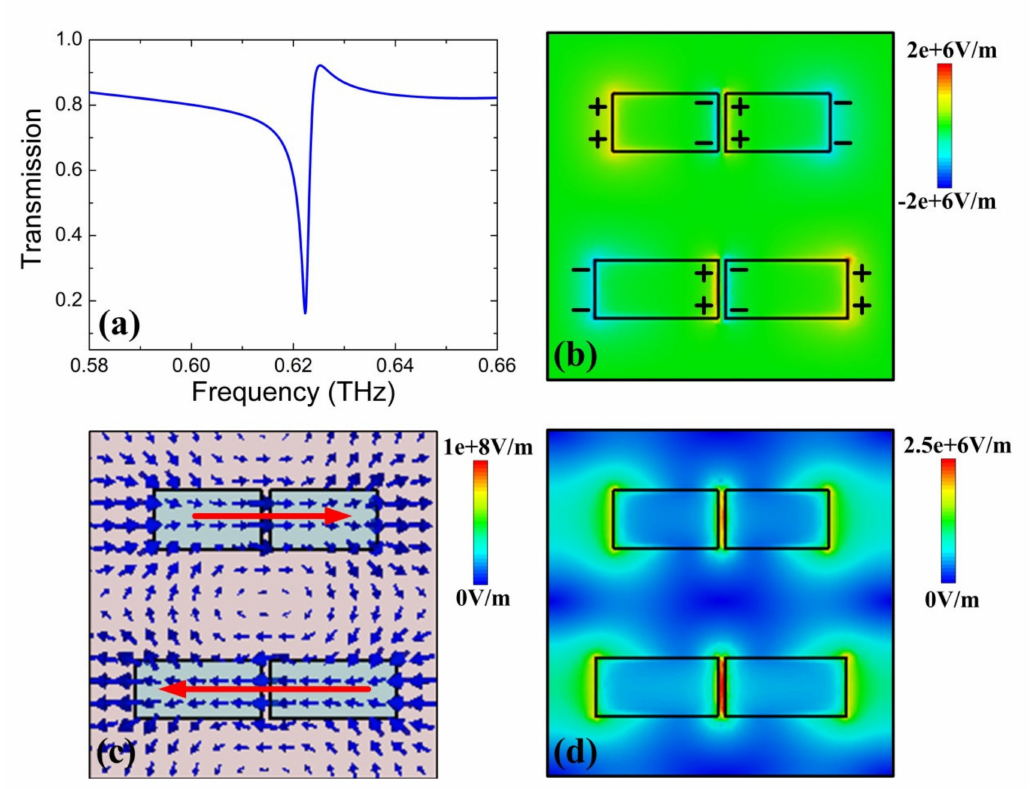
Figure 2. ( a ) Transmission spectrum of the proposed metasurface structure. Distributions of ( b ) electric field E z ( c ) displacement currents and ( d ) electric field amplitude | E z | at resonance dip. The red arrows indicate directions of displacement currents.